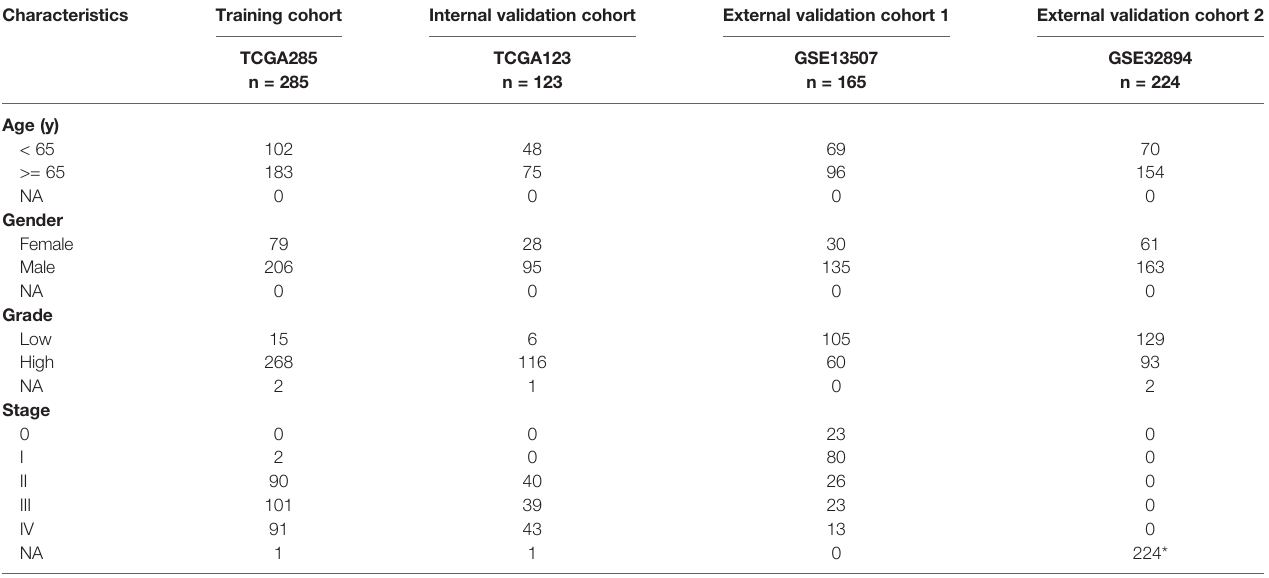
TABLE 1 | Characteristics of patients in training cohort and validation cohorts from open databases.